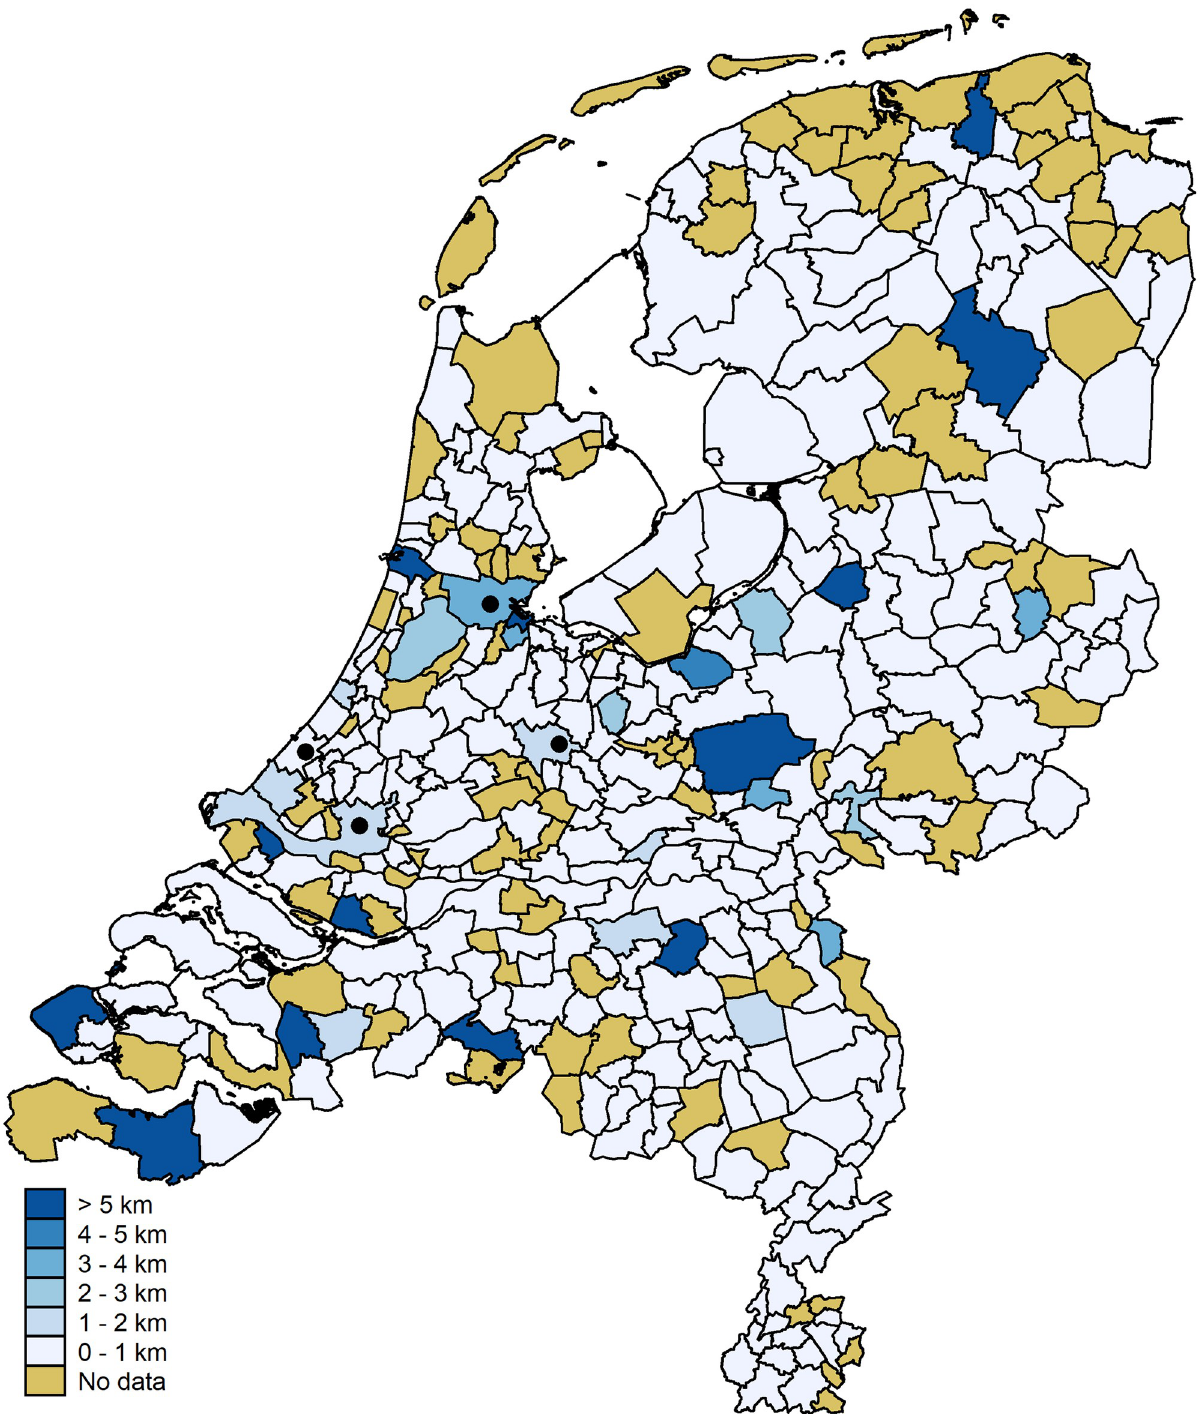
Fig 12. Average distance error per municipality for network domain not set . Digital geometry (i.e., the shapefile) obtained from CBS/Kadaster [30]).